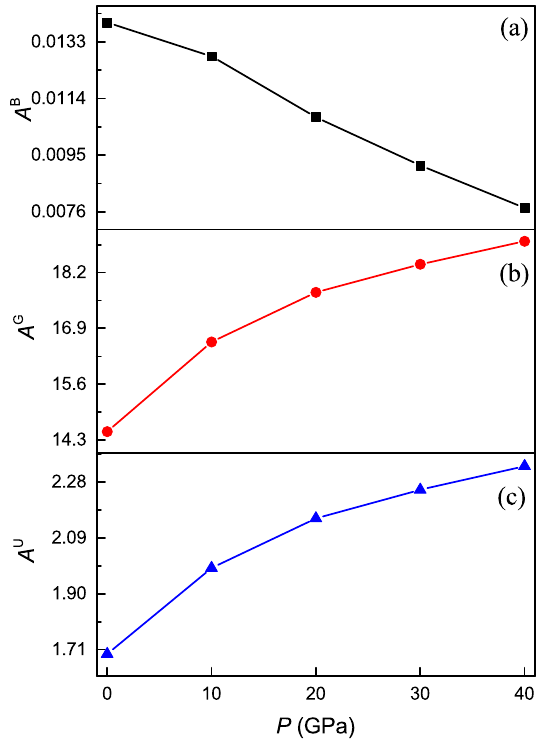
Figure 7. Percentage anisotropy in compressibility ( a ) and shear ( b ), and universal anisotropy ( c ) as a function of pressure for the Ti 4 Nb 3 Al 9 phase.